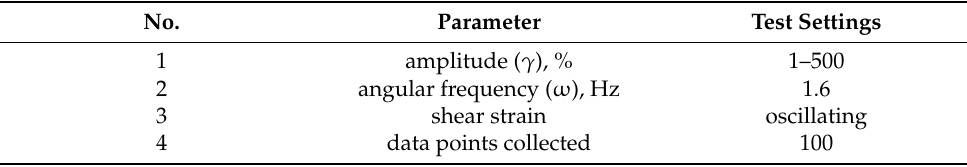
Table 3. The amplitude sweep test parameters.